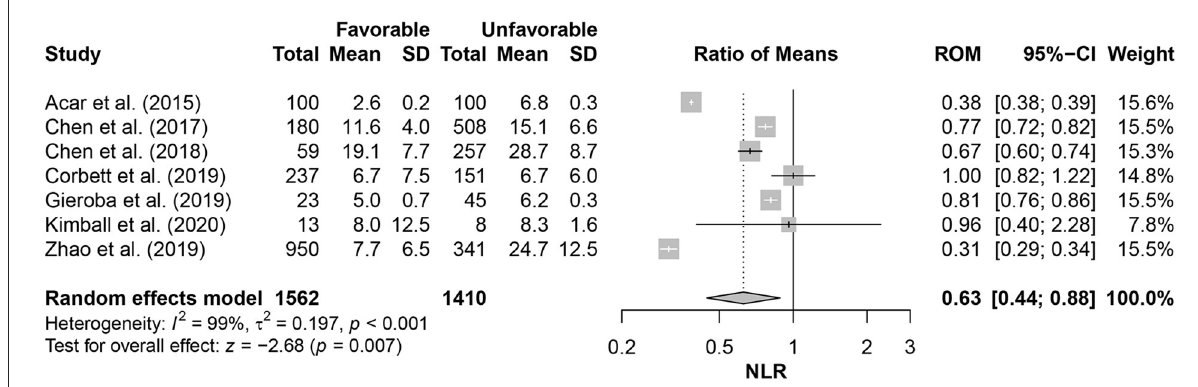
FIGURE2 Comparison of neutrophil-lymphocyte ratio (NLR) in patients with favorable outcomes to those with unfavorable